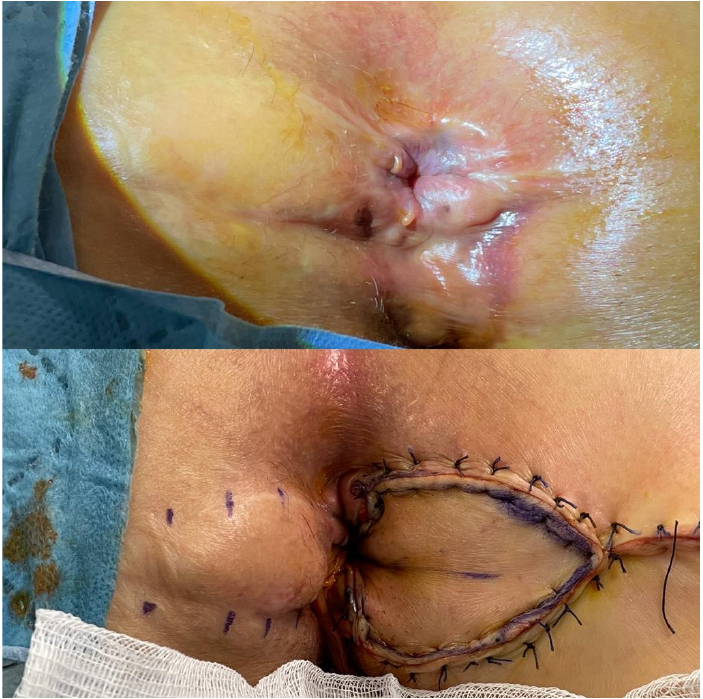
Figure 4. Contralateral diamond flap anoplasty in a patient with recurrent anal stenosis.